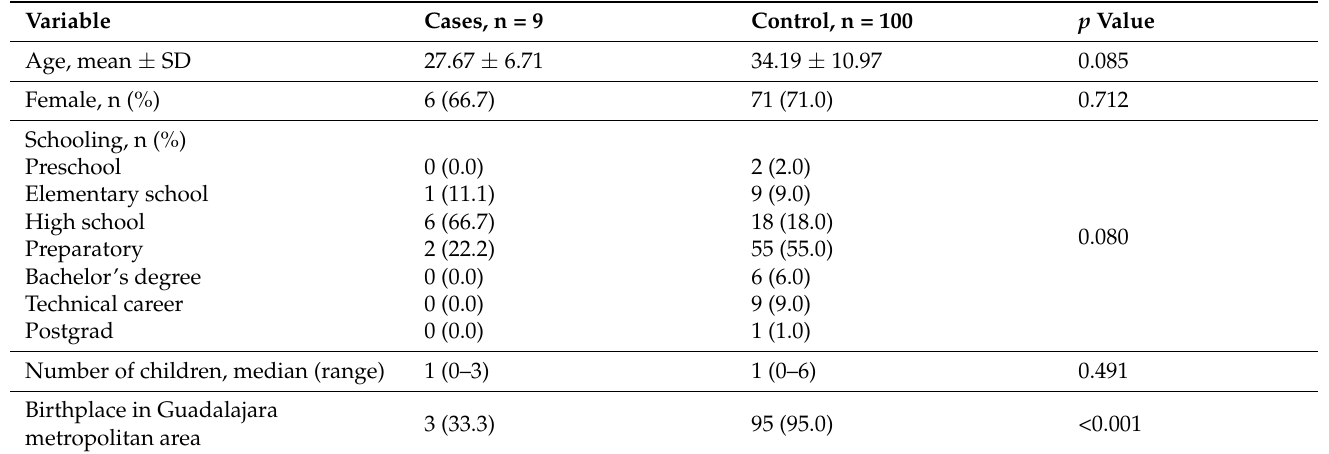
Table 2. Sociodemographic data of participants included in both